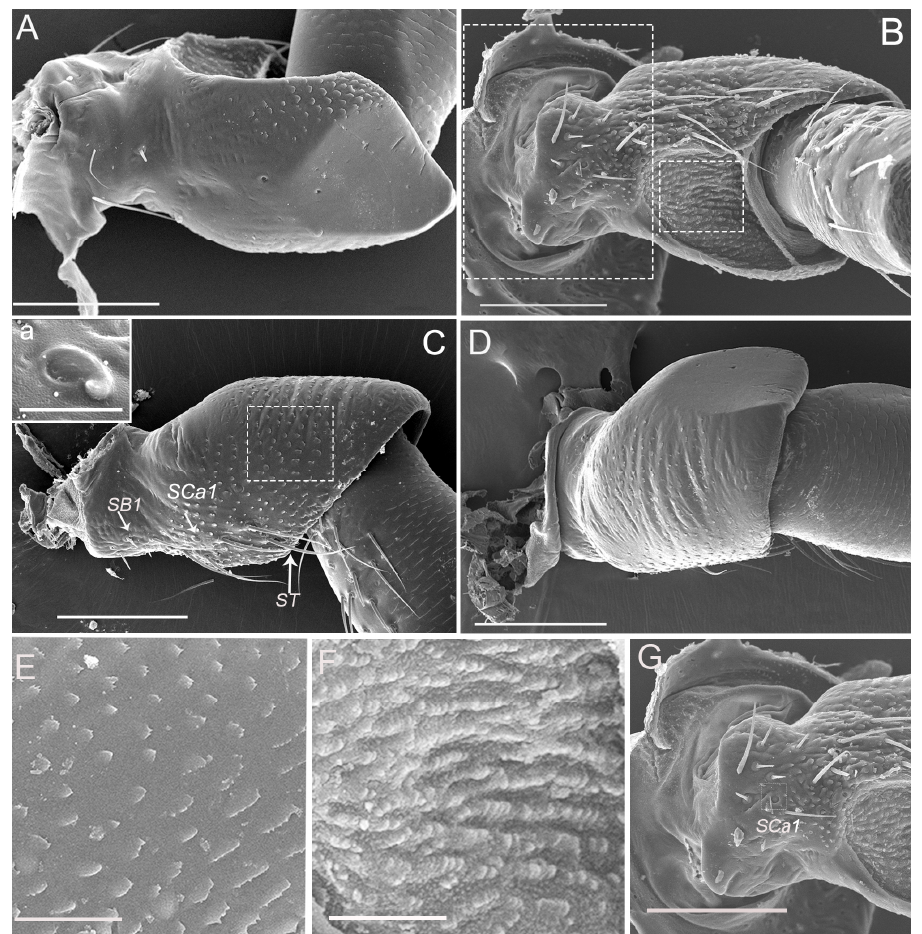
Figure 2. Micrographs showing the scape of an adult Callitettix versicolor’s (Fabricius) right antenna. ( A ) Ventral view; ( B ) Right lateral view; ( C ) Dorsal side showing sensilla trichodea (ST), sensilla basiconica (SB1) and sensilla campaniformia (SCa1); a. High magnification image of SCa1; ( D ) Left lateral view; ( E ) High magnification image of scape surface showing imbricate papillae, indicated by the rectangle given in ( C ); ( F ) High magnification image of the surface of concave on the scape, indicated by the small rectangle given in B); ( G ) High magnification image showing the antenna inserted in antennal foveae on the head capsule, the positions of the images are indicated by the big rectangle given in ( B ). Scale bars: A, B, C, D = 100 μm; E, F = 25 μm; G = 100 μm; a = 5 μm.